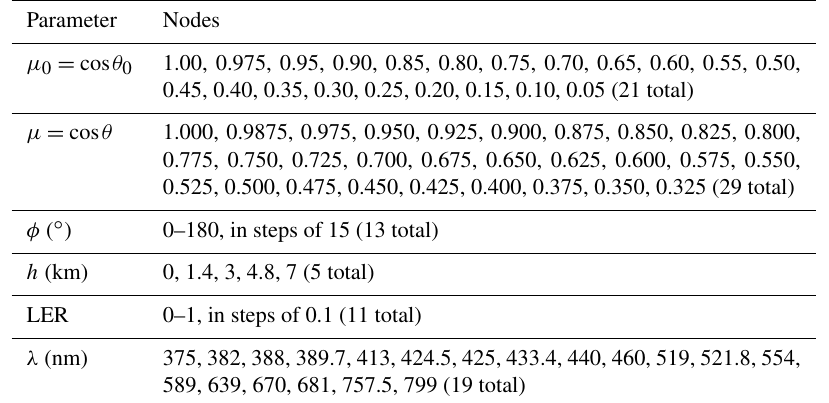
Table 4. Definition of LUT nodes: reduced SZA µ 0 , reduced VZA µ , RAA φ , surface height h , and surface LER. The 5-D LUTs are calculated for 19 wavelengths λ .